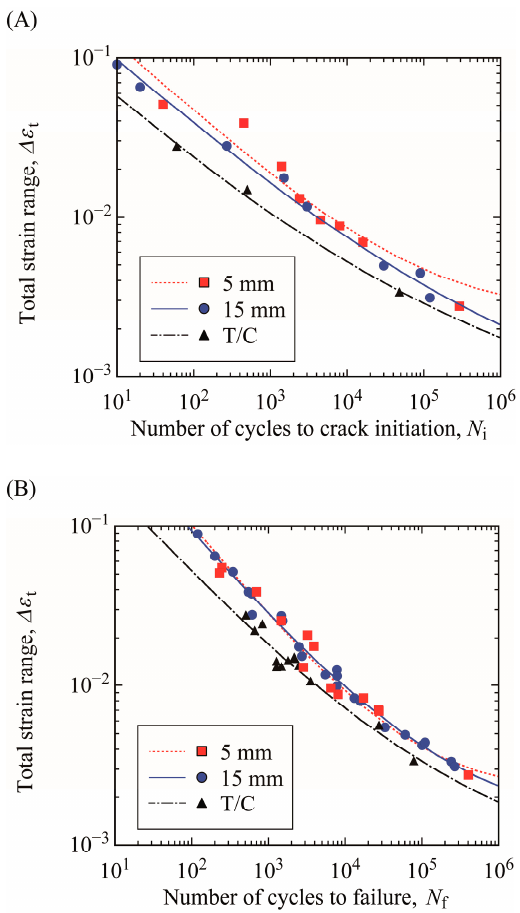
Figure 10. Δ ε t ‐ N relations of bending and T/C testing: ( A ) crack initiation life N i and ( B ) total failure life N f .